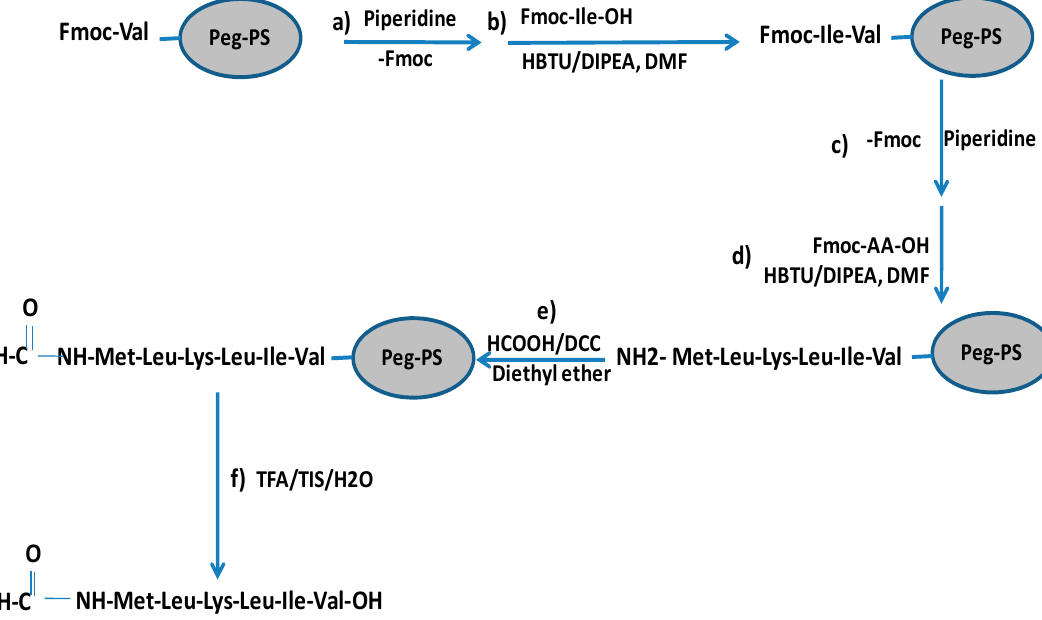
Scheme 1. Synthesis of N -formylated peptide: ( a ) Fmoc deprotection of preloaded resin with the first